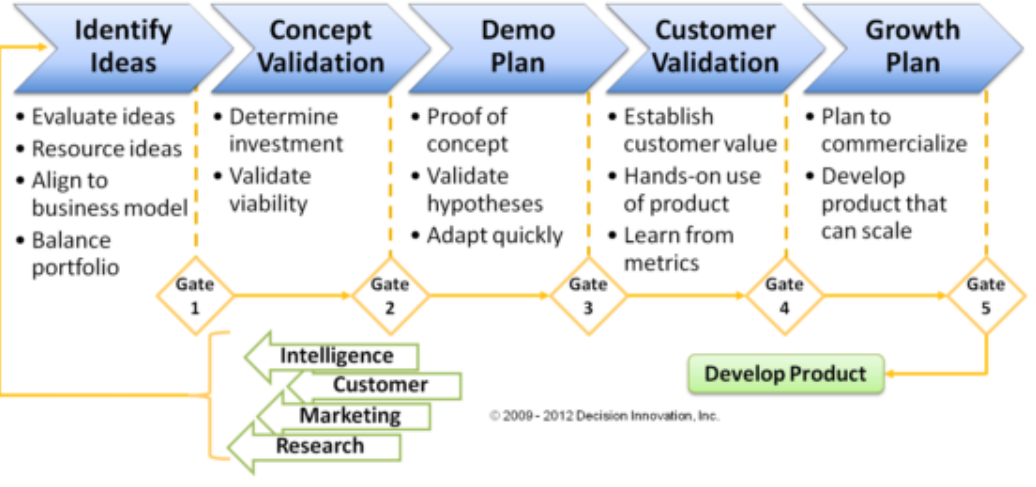
Figure 1: Innovation processes Source: Innovation-Management (2015)